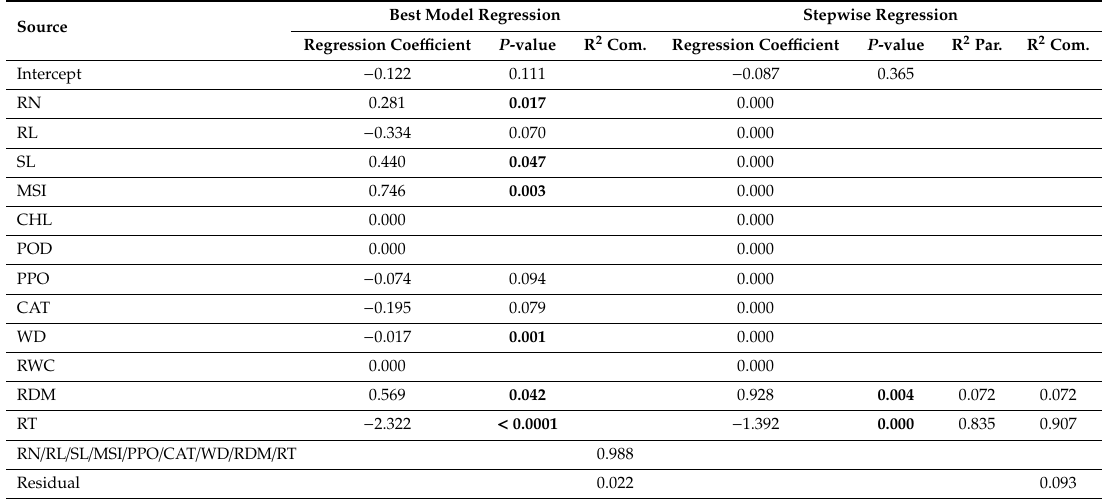
Table 3. Best model and stepwise regression for shoot dry matter (dependent variable) with 12 measured traits (independent